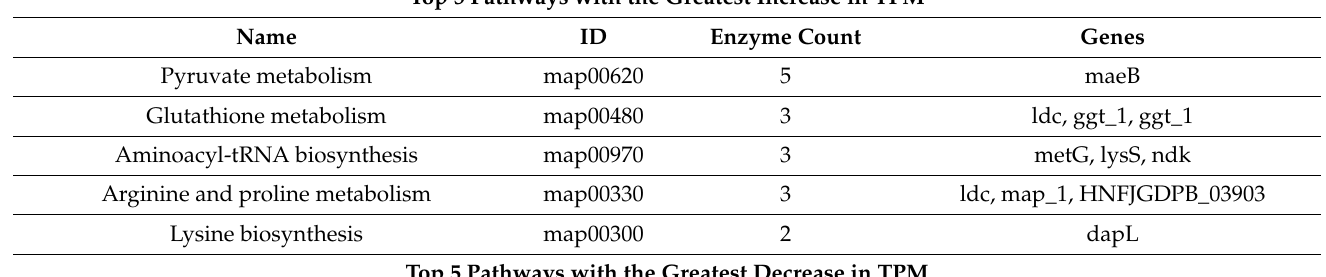
Table 3. KEGG hits for pathways expressed by P. putida in the 1:1 co-culture that exhibit the greatest changes in TPM compared to its metabolic activity in pure cultures. Top 5 Pathways with the Greatest Increase in